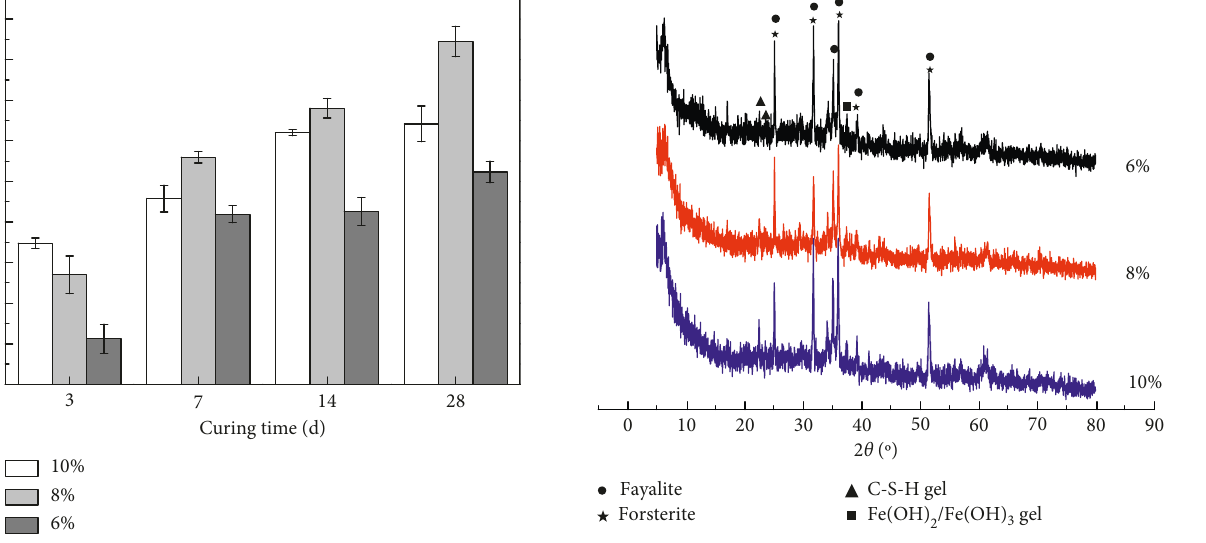
Figure 3: Compressive strength of CNSCMs with different SS contents and curing times.